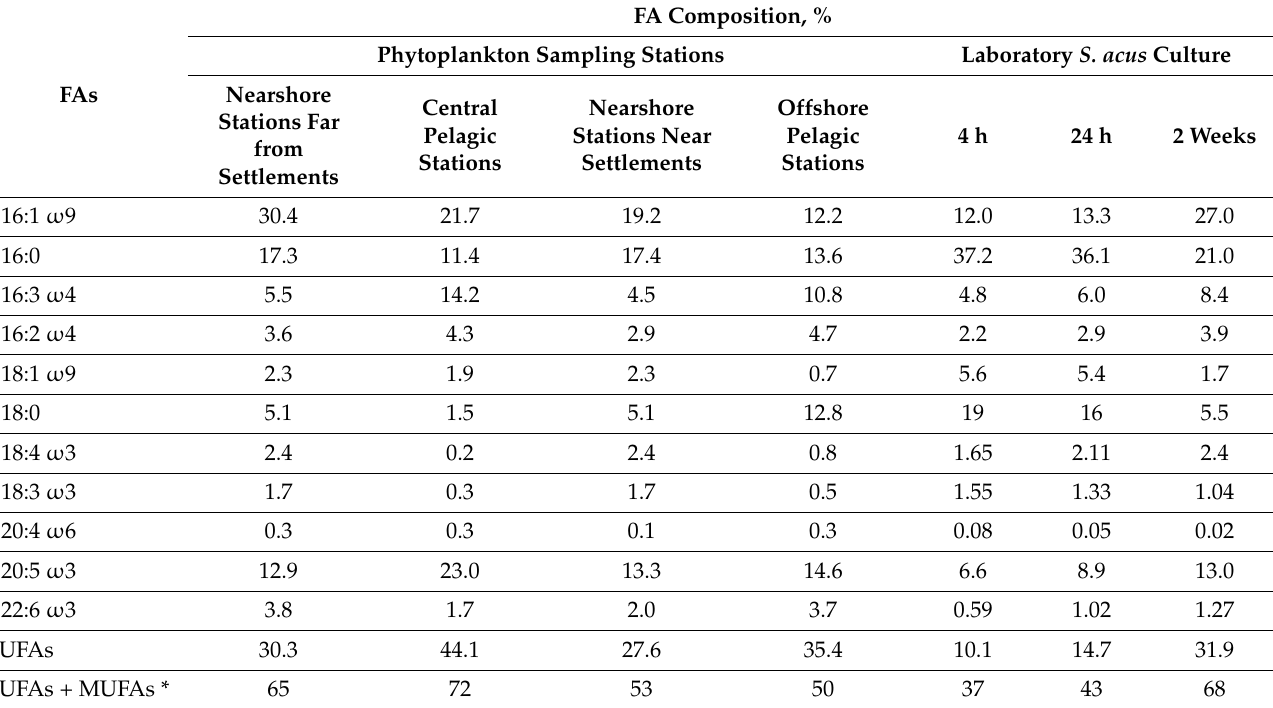
Table 4. FA content averages of natural phytoplankton and laboratory culture of S. acus